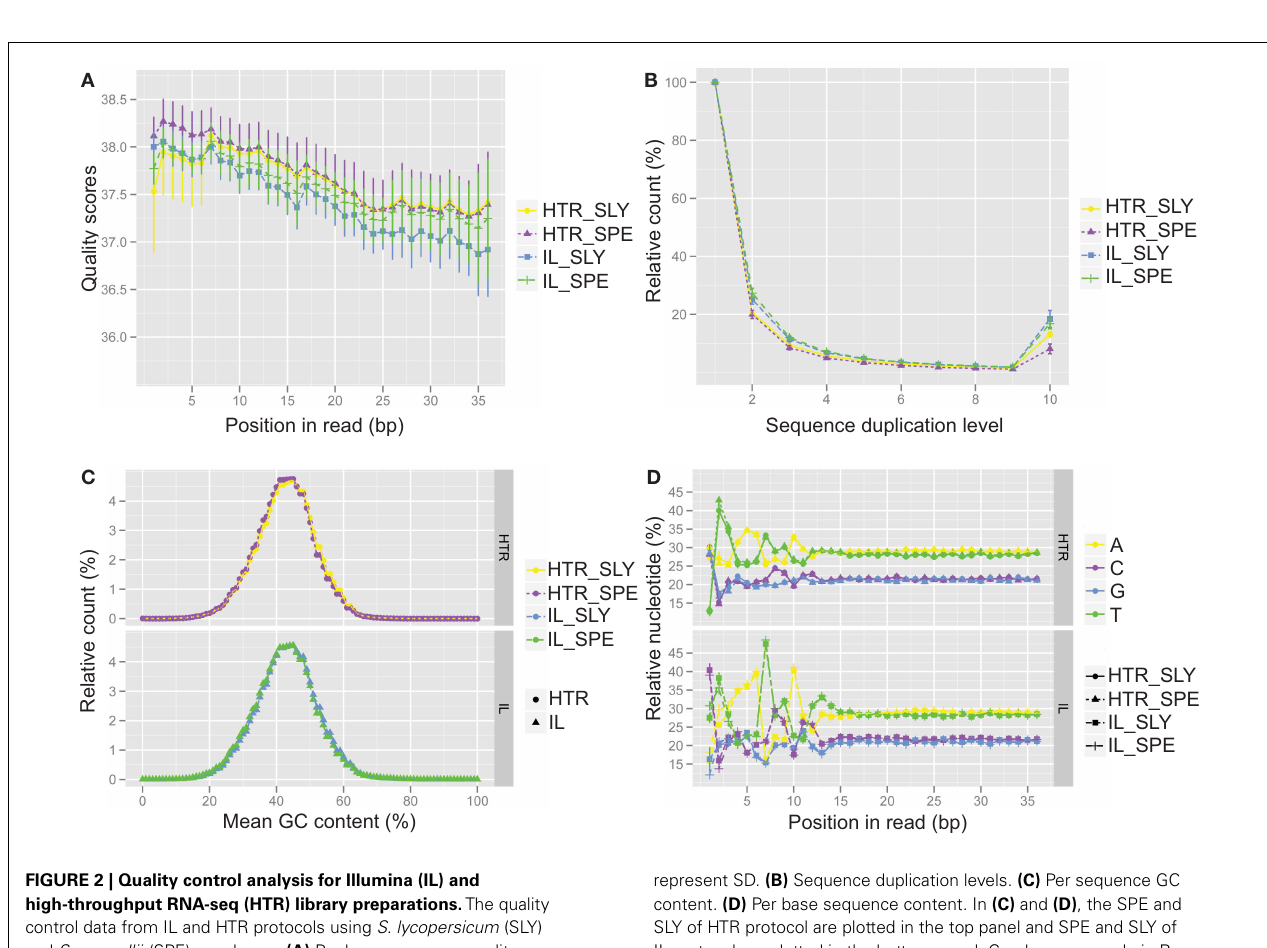
FIGURE 2 | Quality control analysis for Illumina (IL) and high-throughput RNA-seq (HTR) library preparations. The quality control data from IL and HTR protocols using S. lycopersicum (SLY) and S. pennellii (SPE) are shown. (A) Per base sequence quality. Average of the four replicates has been plotted here. Error bars